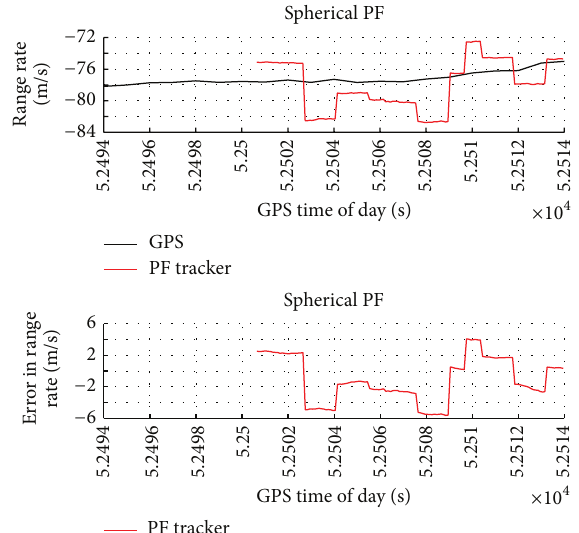
Figure 8: Range rate as estimated by GPS and by radar-only tracker and estimation error as a function of GPS time of